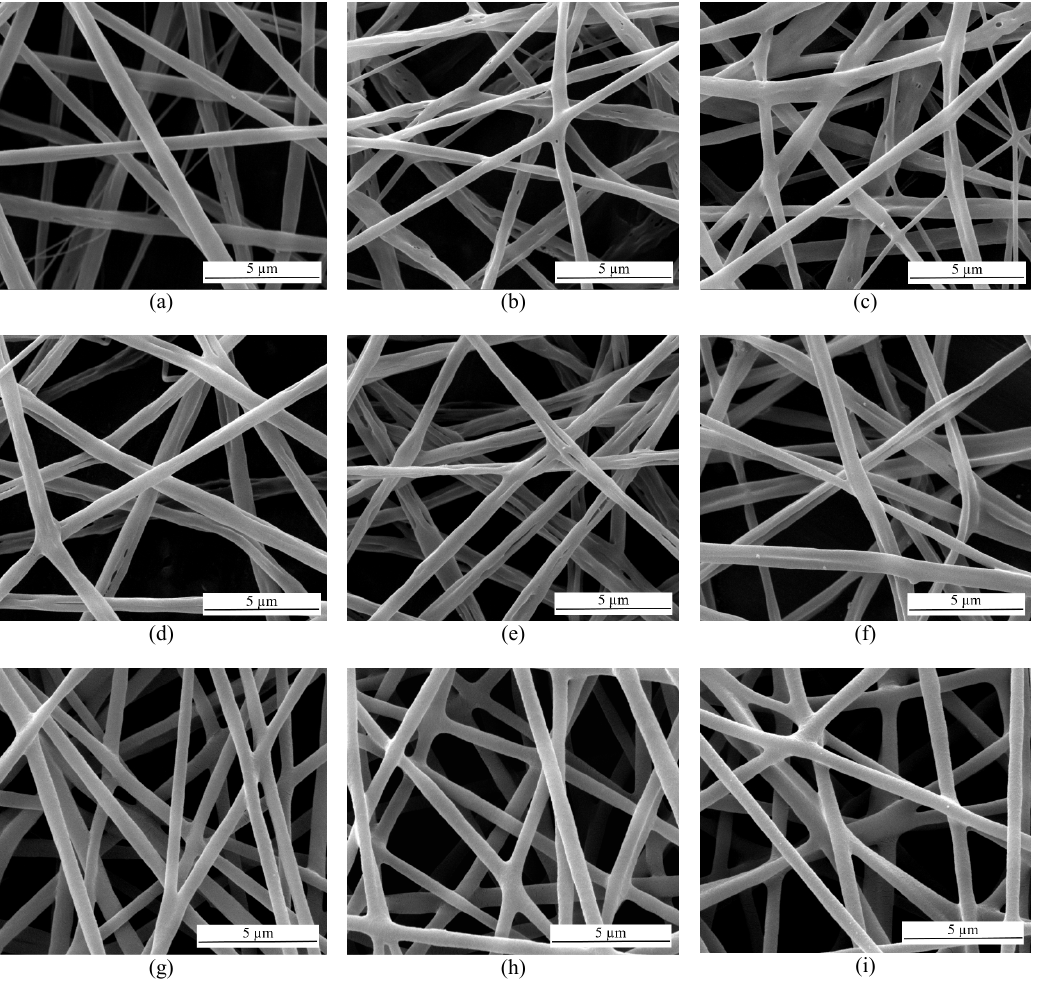
Figure 1. SEM images of the PLA/PEO fiber blend prepared at different polymer concentrations and PLA/PEO ratios: ( a ) 8% PLA/PEO (90:10), ( b ) 8% PLA/PEO (80:20), ( c ) 8% PLA/PEO (70:30), ( d ) 10% PLA/PEO (90:10), ( e ) 10% PLA/PEO (80:20), ( f ) 10% PLA/PEO (70:30), ( g ) 12% PLA/PEO (90:10), ( h ) 12% PLA/PEO (80:20), and ( i ) 12% PLA/PEO (70:30).